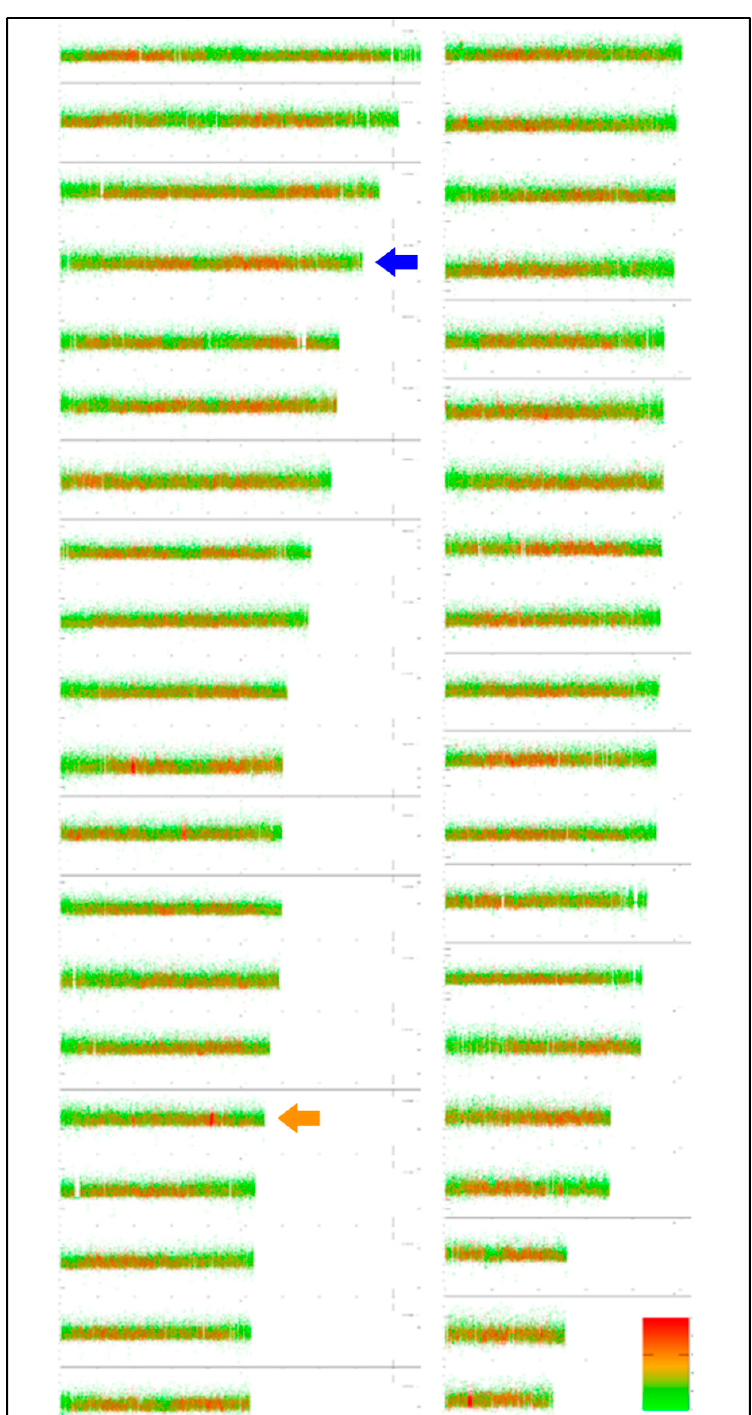
Figure 3. Virtual karyotype of Salmo trutta shows the haploid set of size-sorted chromosomes. The colour scale represents the proportion of repetitive (green) and non-repetitive (red) sequences. The y axis of each chromosome represents the scale of GC%. The karyotype based on cytogenetics in S. trutta enables us to roughly identify only the first three chromosomes according to their size—the largest acrocentric, the largest sub-telocentric and probably the largest metacentric chromosome. According to Ensembl, the 5S rDNA bearing chromosomes are chromosome No. 1 (the main site visualized also by FISH, blue arrow), i.e., the fourth largest chromosome, and chromosome No. 20 (orange arrow), which has a single 5S rDNA sequence.